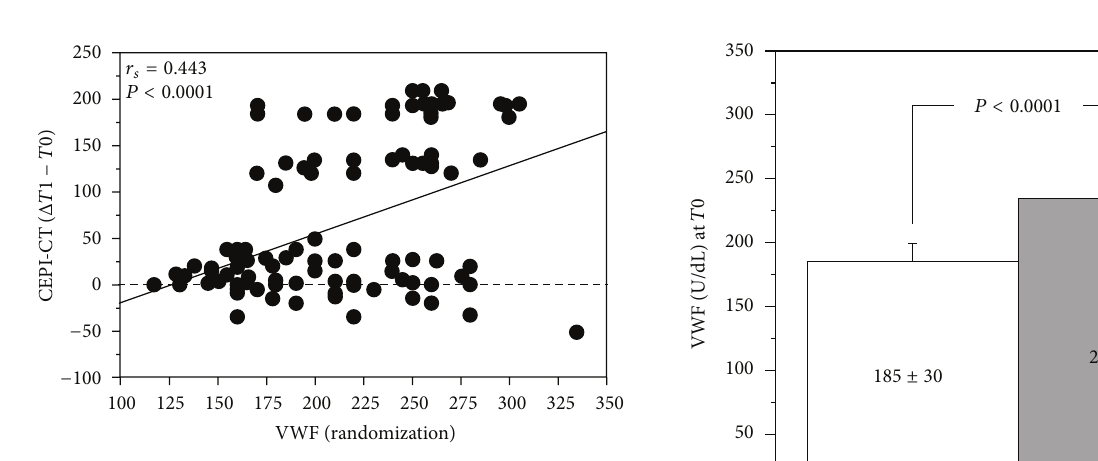
Figure 4: Results of LTA with arachidonic acid and ADP G0 and G1 at 5, 30, and 180 days following PCI.